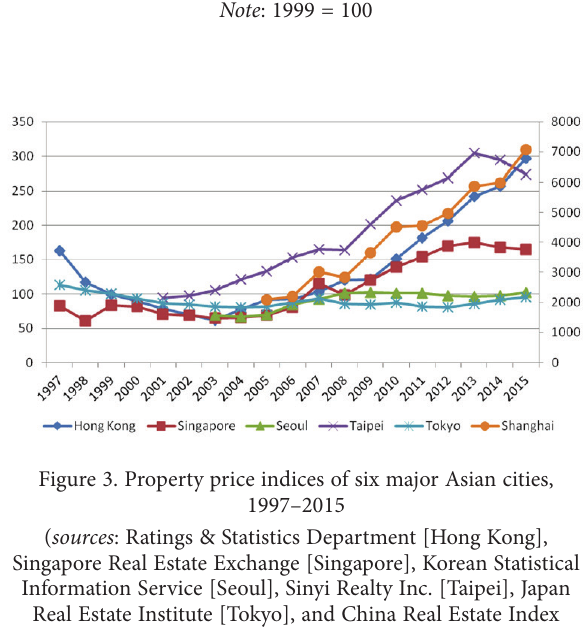
Figure 5. Supply of land for residential development from 1991 to 2014 (in thousand m²) ( source : Lands